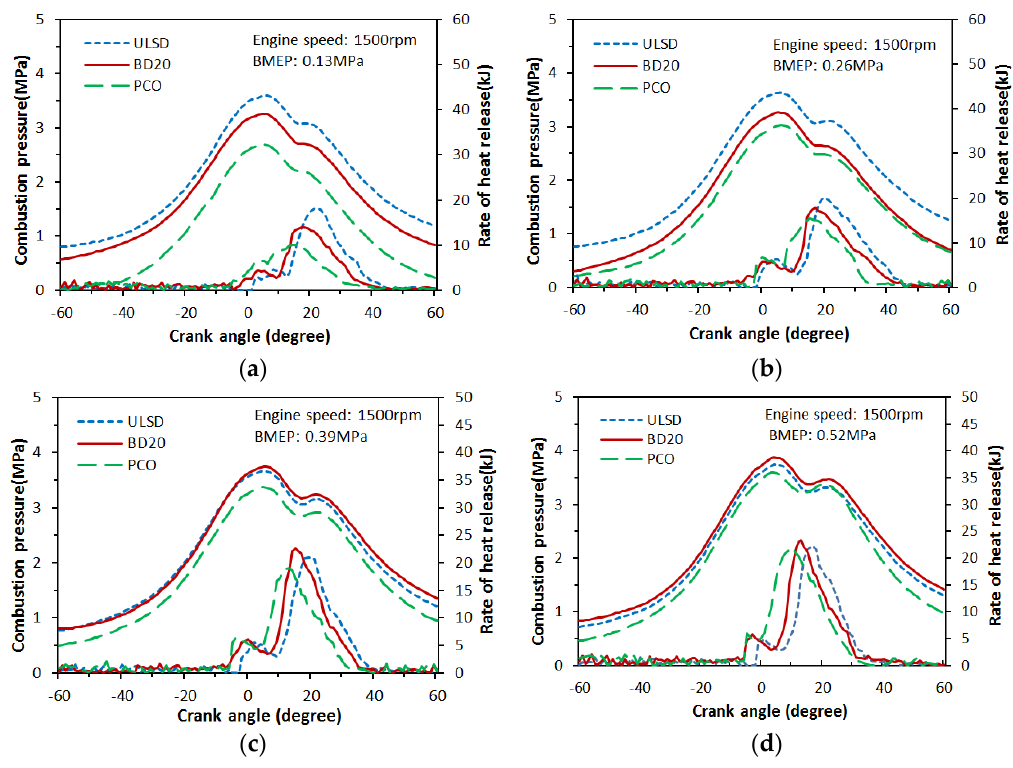
Figure 3. Effect of test fuels on combustion pressure and ROHR (Rate of Heat Release) at various BMEPs (brake mean effective pressures). ( a ) 0.13 MPa; ( b ) 0.26 MPa; ( c ) 0.39 MPa; ( d ) 0.52 MPa.